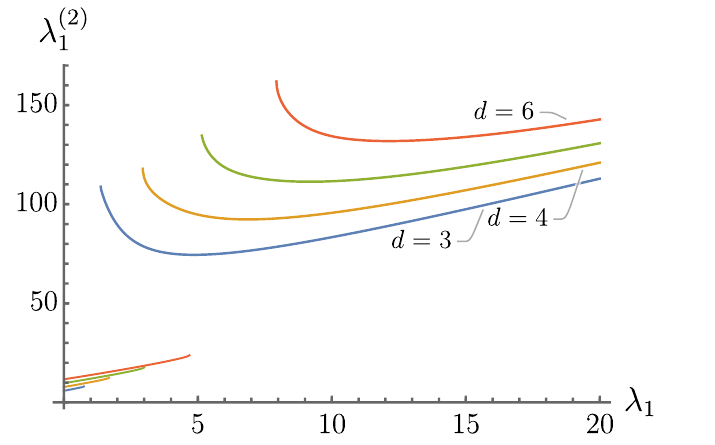
Figure 5 . Upper bounds on the second nonzero eigenvalue of the Laplace-Beltrami operator, in terms of the first nonzero eigenvalue, on closed hyperbolic manifolds of dimension d ∈ { 2 , 3 , 4 , 5 , 6 } . The same bounds apply for any pair of consecutive nonzero eigenvalues.